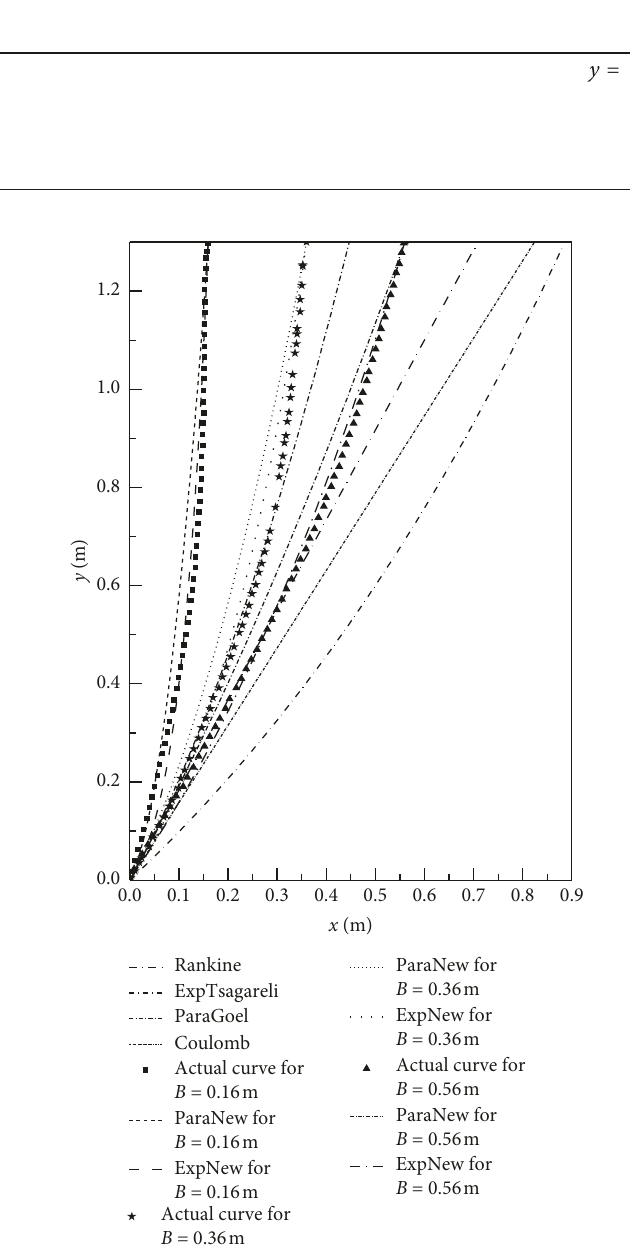
Figure 2: Performance of various equations of the slip surface.